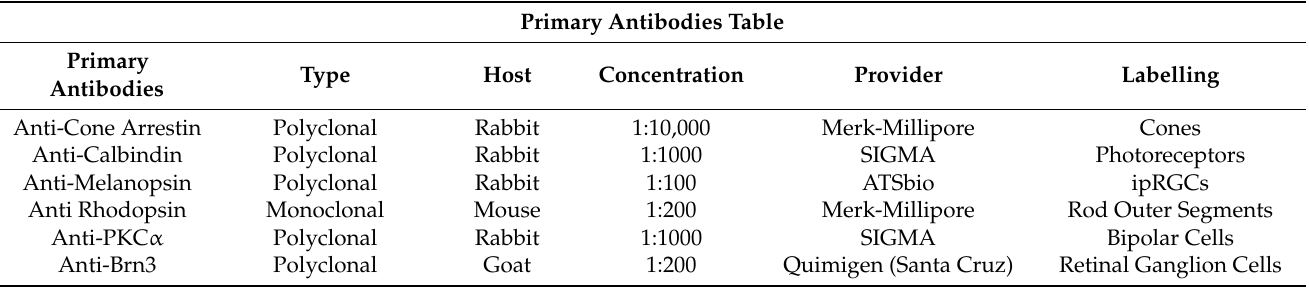
Table 1. Primary antibodies used in the labeling of the different cell types of the retina. Primary Antibodies